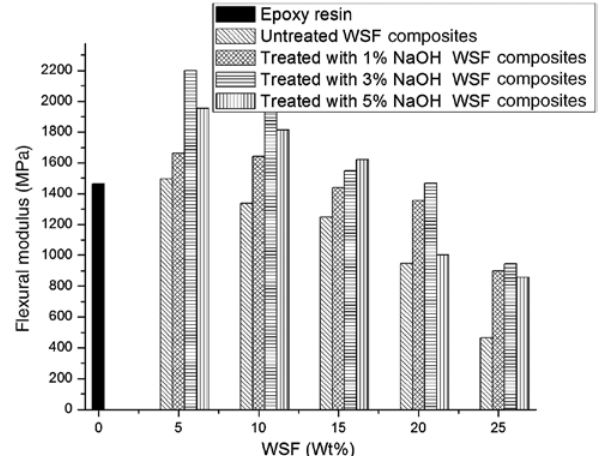
Figure 4: Effect of fiber content and alkali treatment on the flexural modulus of WSF-epoxy composites.